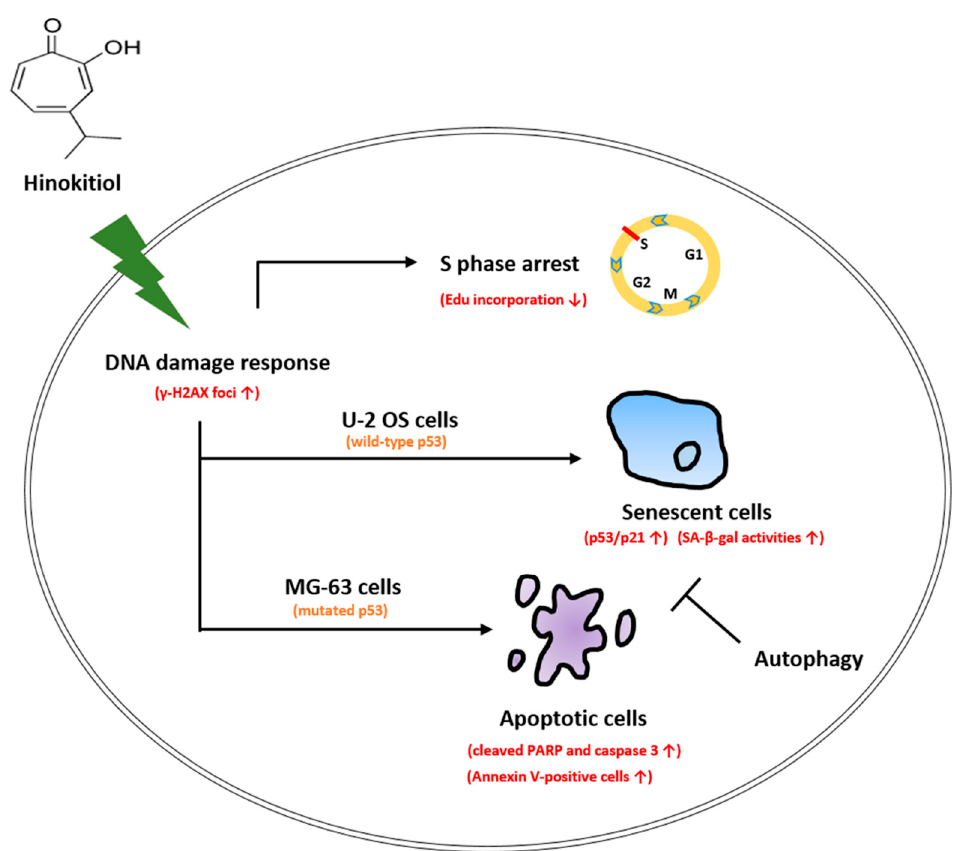
Figure 8. Schematic presentation of the hypothetical mechanisms for the role of hinokitiol in inhibiting osteosarcoma cell lines.